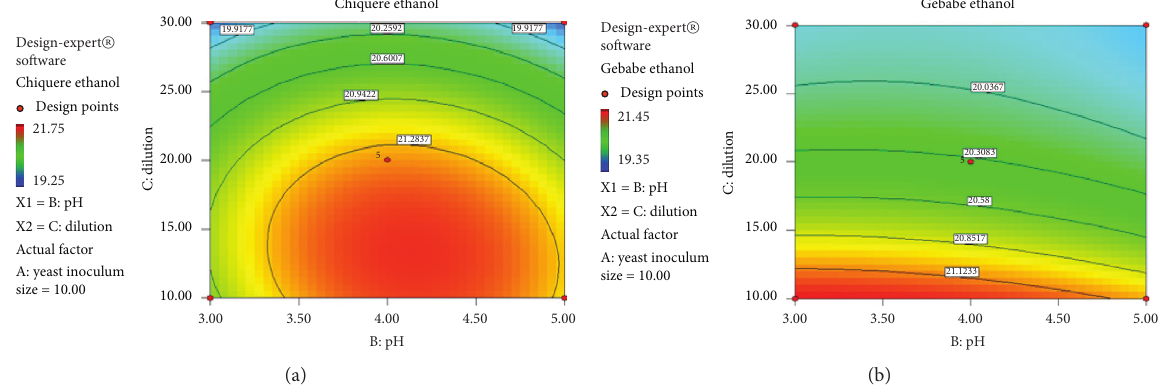
Figure 6: Contour plot for the effect of pH and dilution factor on ethanol yield. (a) Chiquere variety; (b) Gebabe